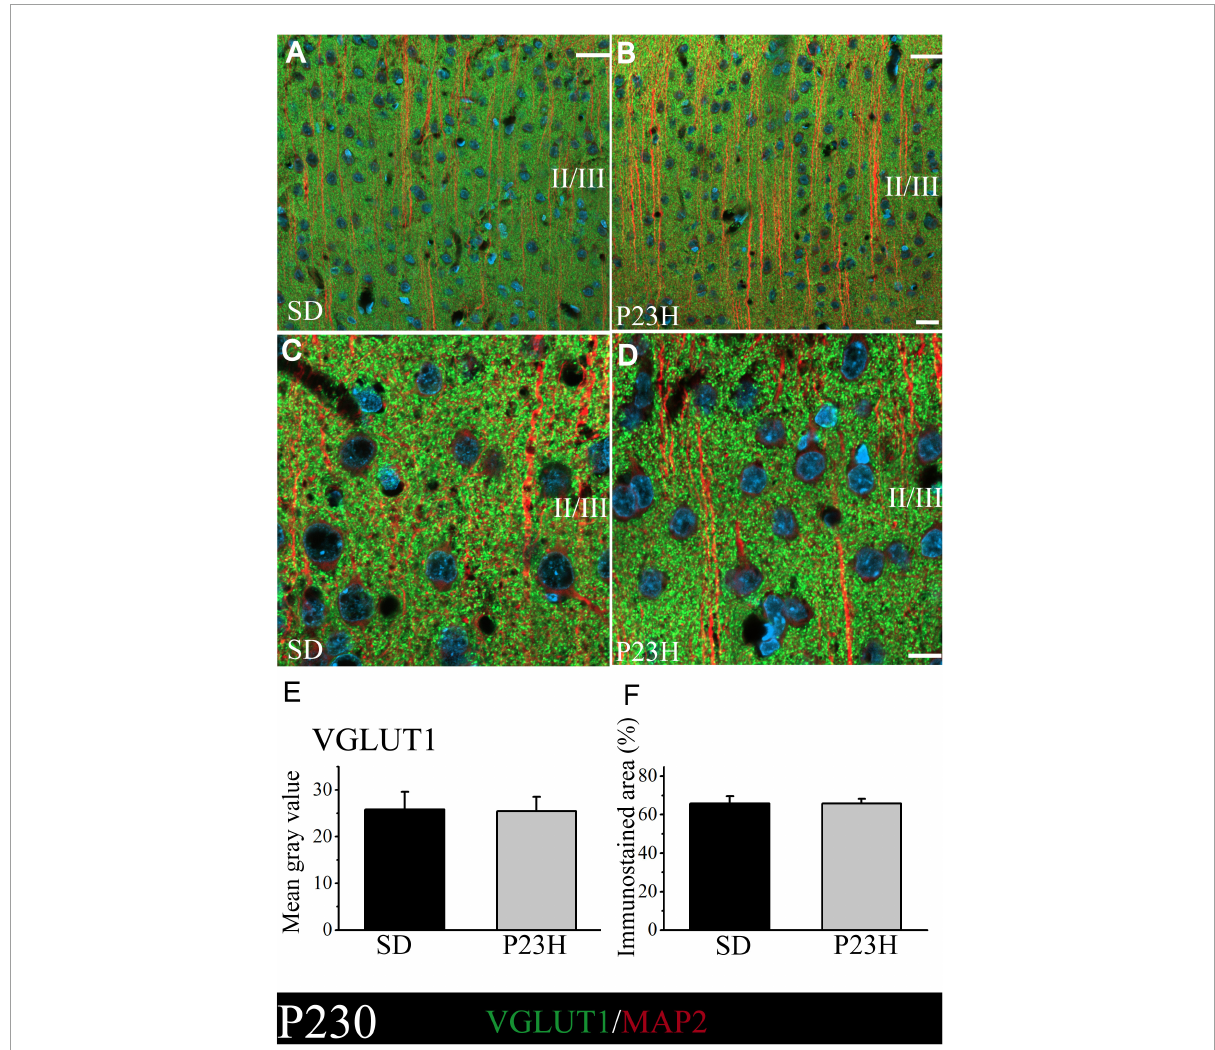
FIGURE3 VGLUT1 and MAP2 immunolabeling at P230 in the visual cortices of the SD and P23H rats at P230. (A,B) Confocal images of the VGLUT1-ir presynaptic structures (green) and MAP2-ir somata and dendrites (red) along the supragranular layers of the visual cortices of the adult SD and P23H rats. Nuclei are counterstained with DAPI (blue). (C,D) High-magnification confocal images of VGLUT1 and MAP2 immunolabeling of visual cortical layers II/III. The same pattern of VGLUT1 immunolabeling is found for both conditions. (E,F) Quantification of the MGV and % of immunostained areas. No statistically significant differences were found between both conditions. Scale bar: 20 µ